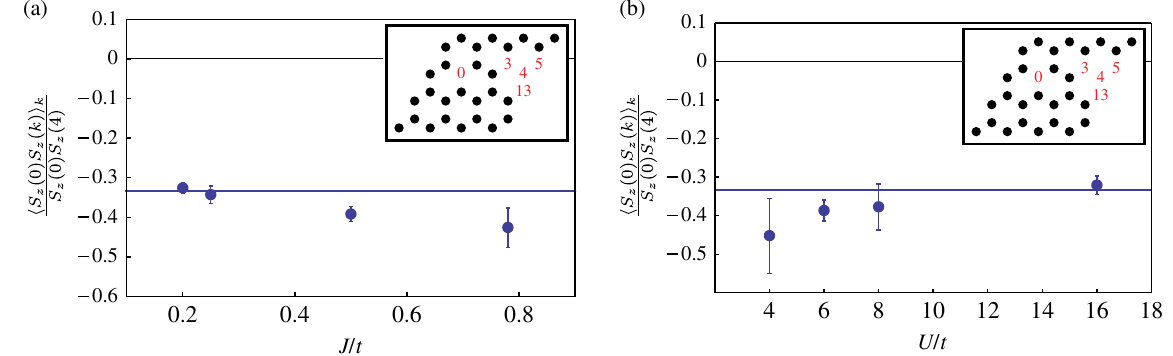
i Þ S j Þi in the CSDWor SCCL phase, with DMRG ground state of 32-site sample FIG. 13. Nature of spin-spin correlation pattern h S z ð z ð projected into sector having center-of-mass momentum Γ , and C 6 eigenvalue exp ð − i π = 3 Þ : (a) t - J model, (b) Hubbard model. Three values of correlation with sites chosen as i ¼ 0 , j ¼ 3 , 5, 13 (see inset) are averaged, and that average is divided by correlation between i ¼ 0 , j ¼ 4 . Tetrahedral pattern predicts this ratio to be − 1 = 3 (blue line). Correlation for each site pair i , j is averaged over all translationally related pairs to reduce statistical error.